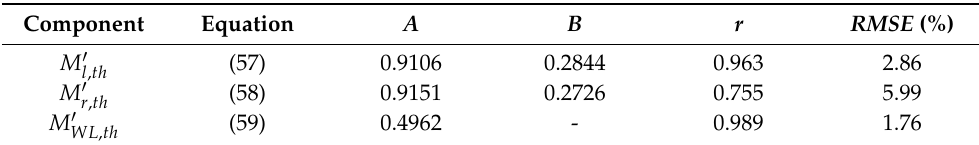
Table 2. Performance of proposed theoretical methods to evaluate disinfectant mass loss components with network model